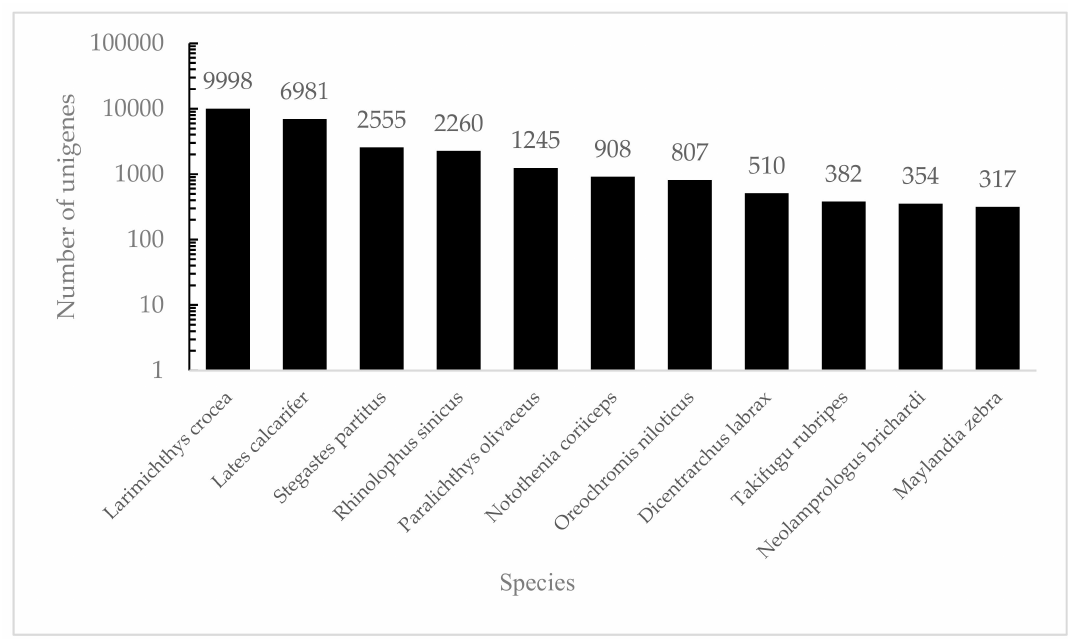
Figure 1. The species distribution of the results of NR annotation. Vertical axes: the number of annotated sequences matching each species. Horizontal axes: the distribution of top species that match the annotated